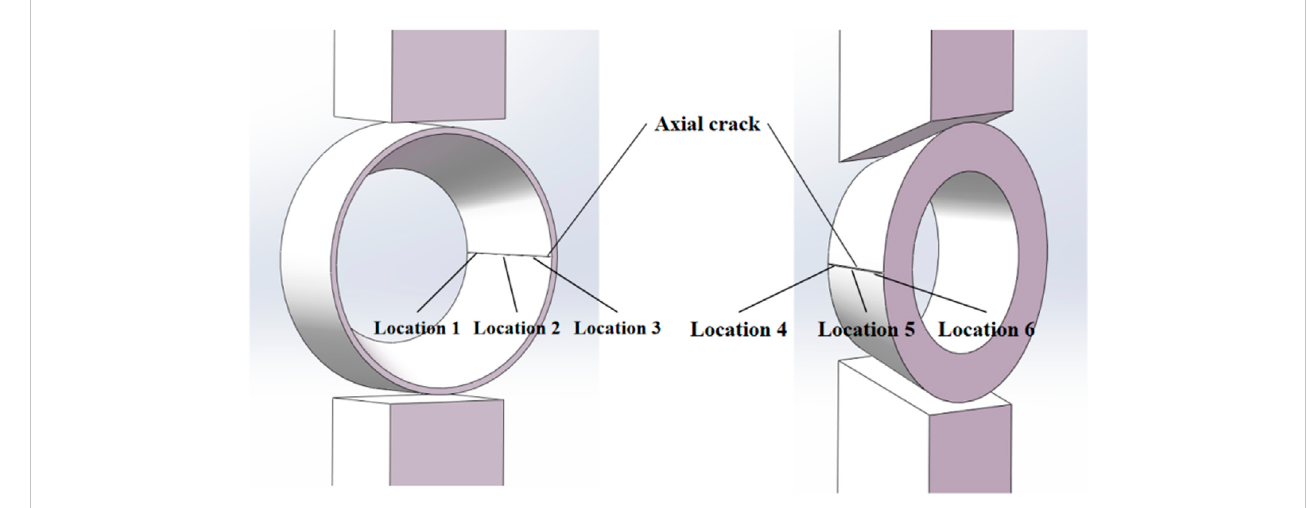
FIGURE 2 Magnetization model of bearing ring.